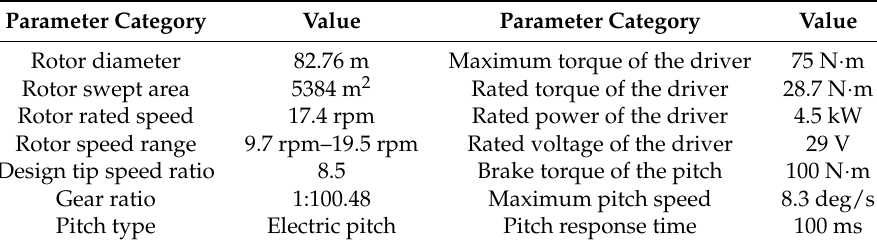
Table 1. Modeling